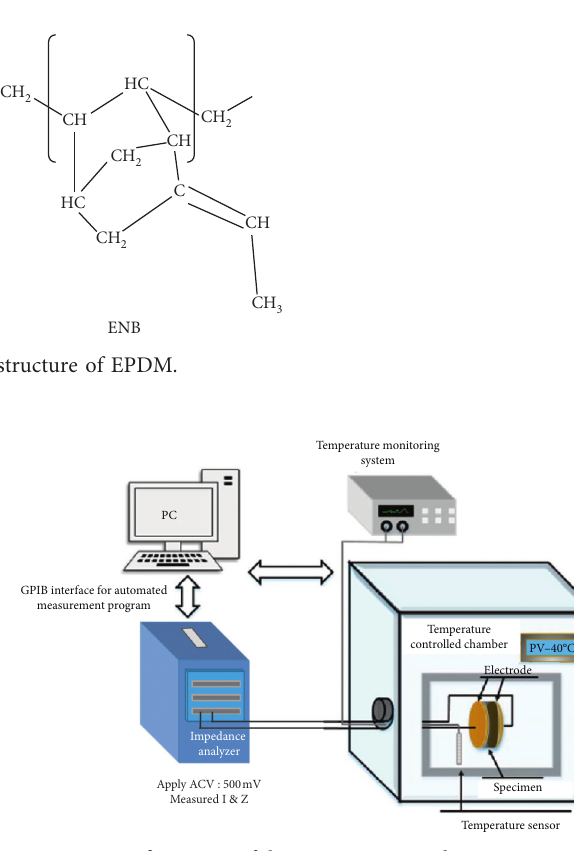
Figure 4: Configuration of the automatic impedance spectroscopy system for complex dielectric permittivity measurements versus frequency and temperature.